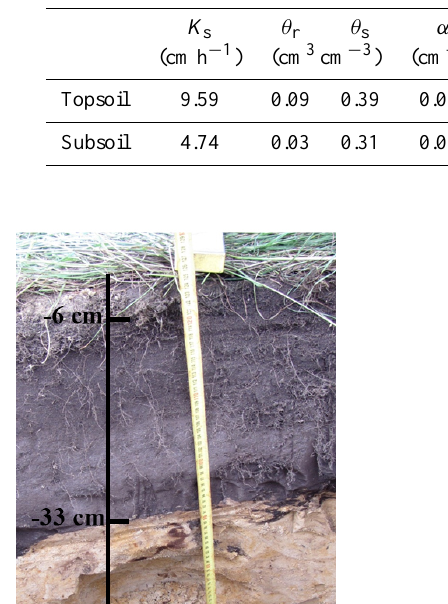
Figure 1. Geographical location of the experimental field and the map of the apparent soil electrical conductivity (EC a ) of the study site corresponding to three different zones of groundwater levels (GWL). The black star on the EC a map indicates the sensor location. Table 1. Average of soil properties of soil profile: θ r , θ s are residual and saturated water content, respectively; α and n are shape parameters for the van Genuchten–Mualem equation. K s denotes the saturated hydraulic conductivity.